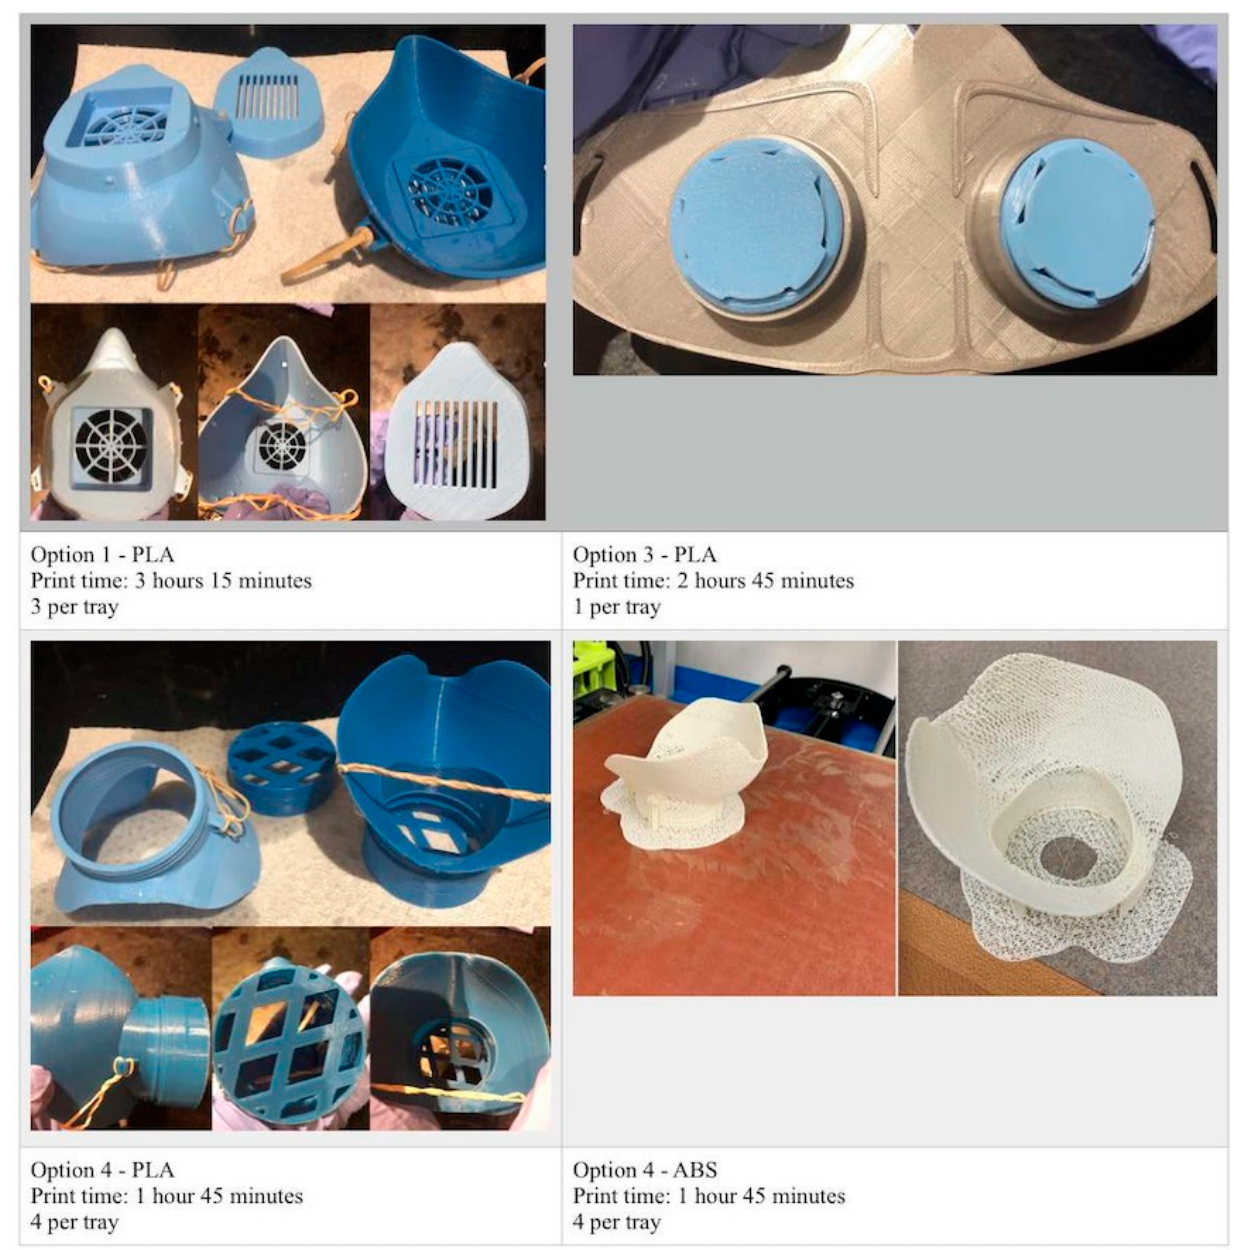
Figure 10. Typical image of fabricated masks using PLA and ABS [54].